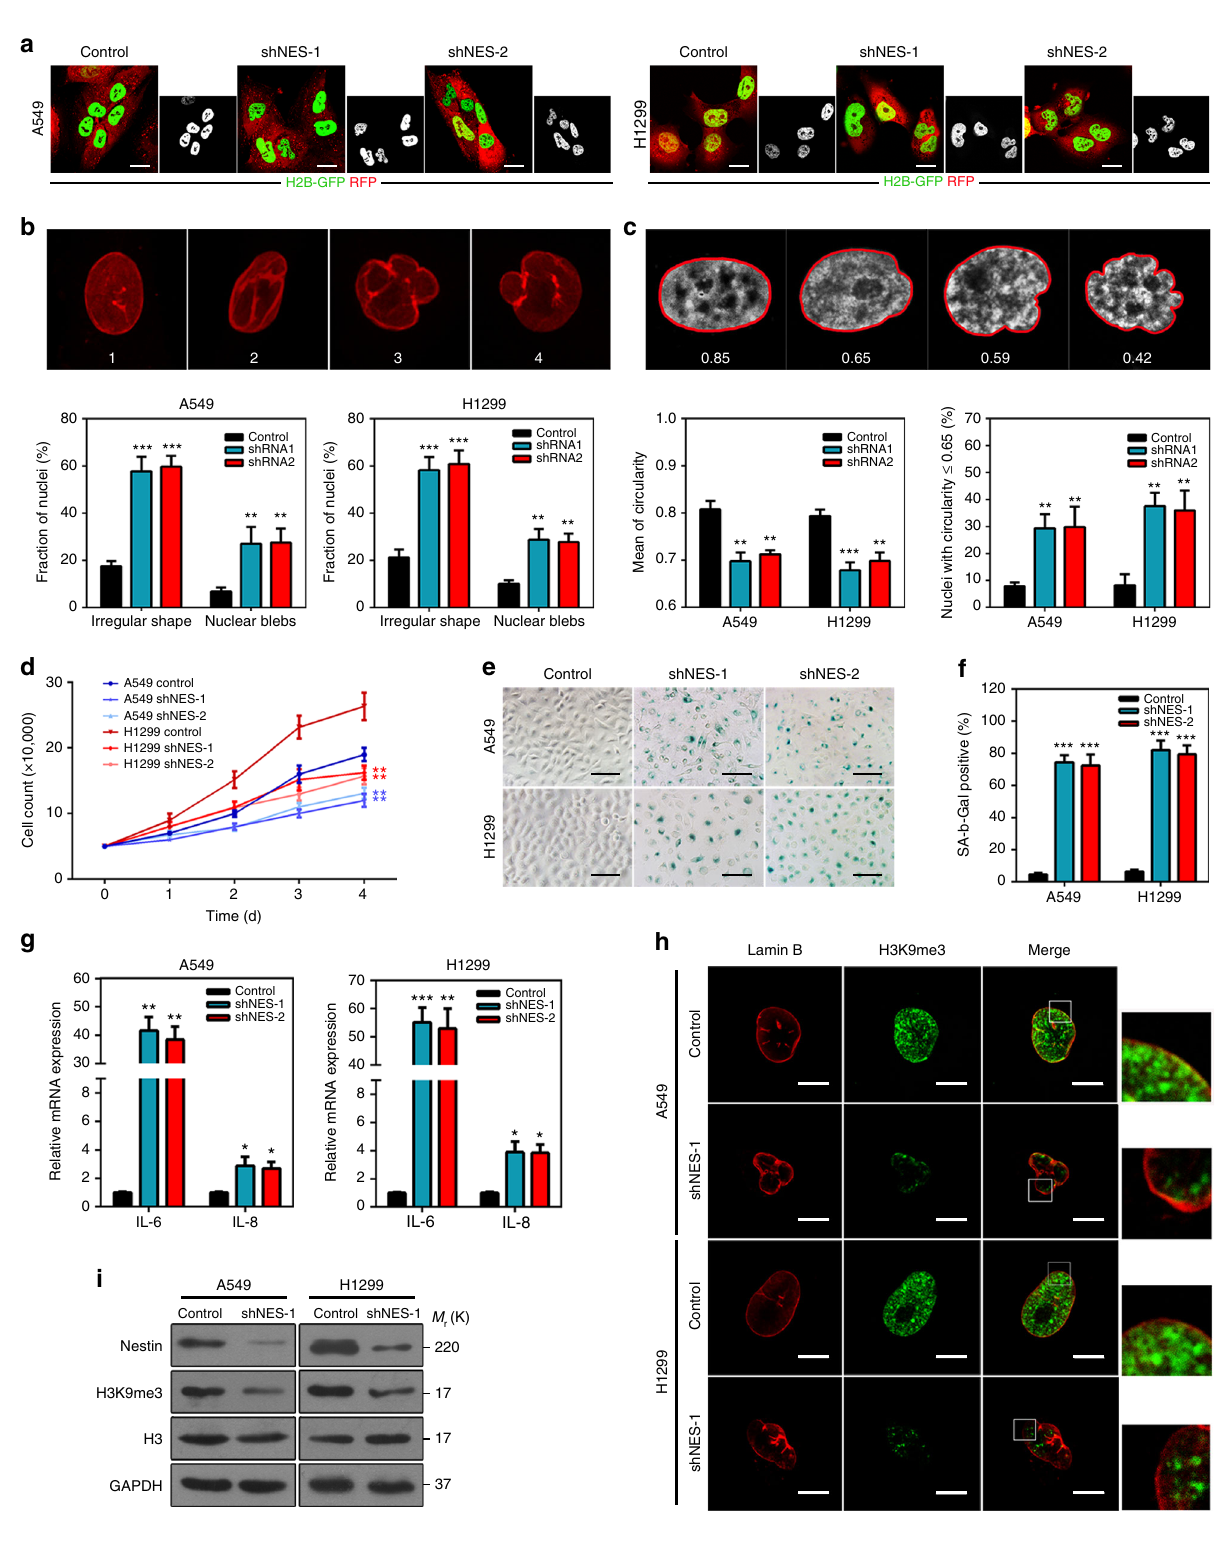
(T7E1) assay 36 (Supplementary Fig. 2a, b). The functional gRNA was selected for further analysis (Supplementary Fig. 2c). Consistent with the above-described results, the fraction of abnormally shaped nuclei was signi fi cantly increased in H1299 cells transfected with Cas9/gRNA, as assessed 4 days